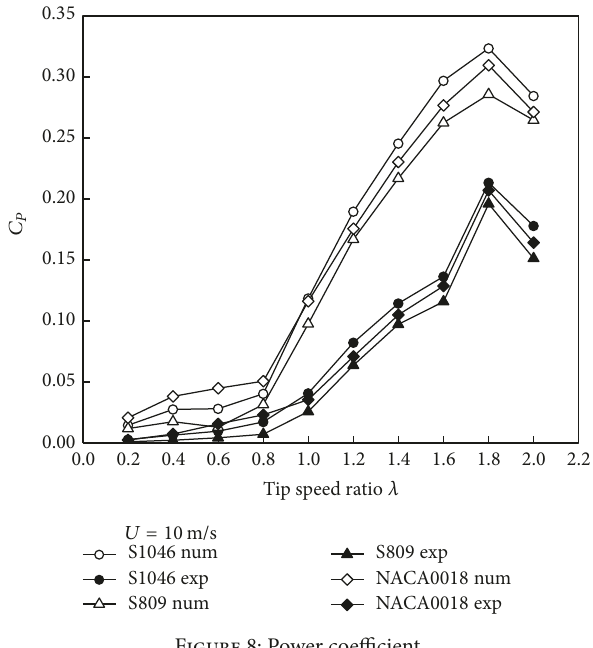
Figure 8: Power coefficient.